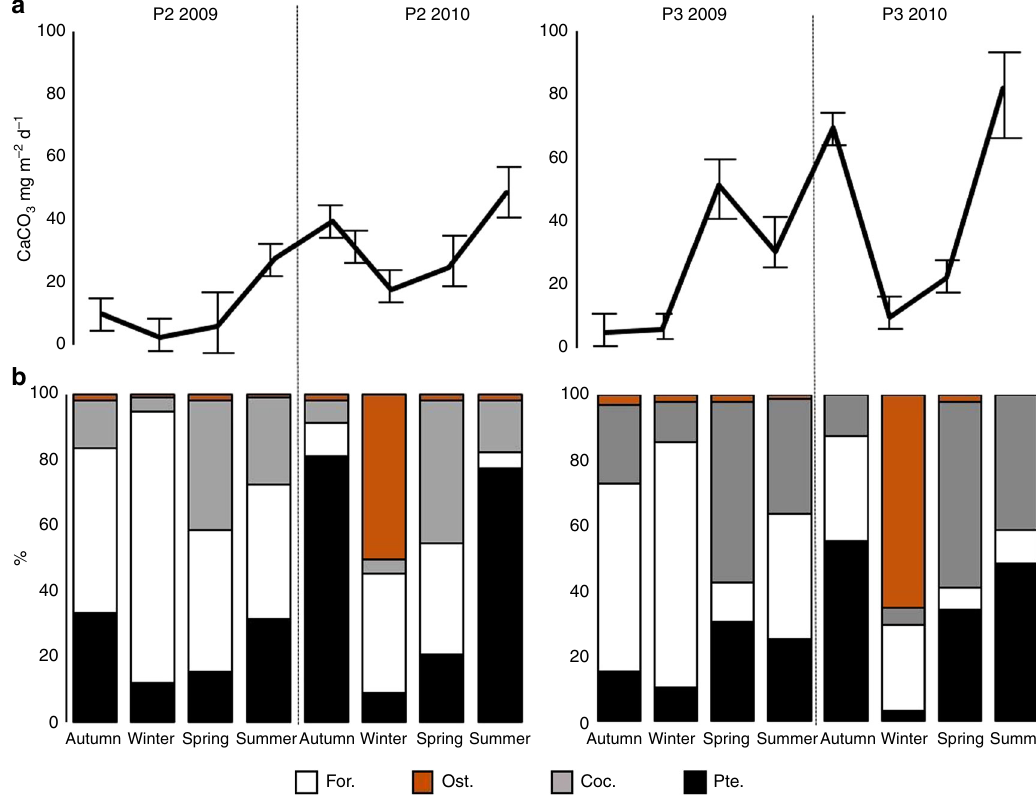
Fig. 1 Seasonal carbonate fl ux. a Seasonal carbonate fl ux (CaCO 3 ) expressed as mg m − 2 d − 1 ; b contribution of planktonic calci fi ers (%) to the total CaCO 3 fl ux, (pteropods, foraminifera, coccolithophores and ostracods) at the two deep moored sediment traps P2 and P3 for each year (2009 and 2010). Error bars indicate 1 standard deviation (replicates n = 8 –